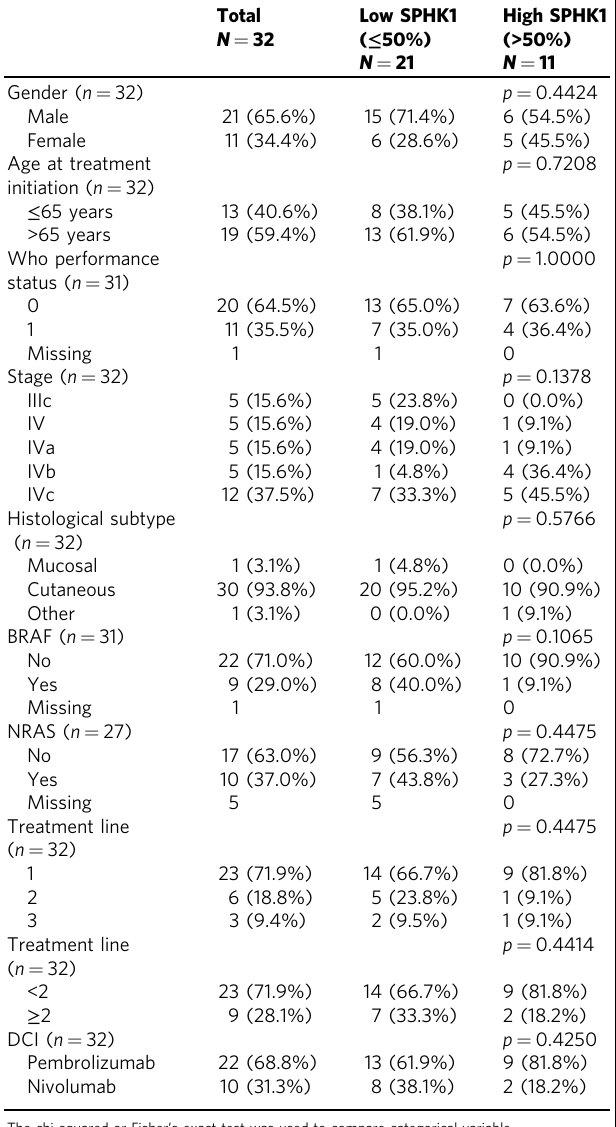
Table 1 Patient demographic and clinical